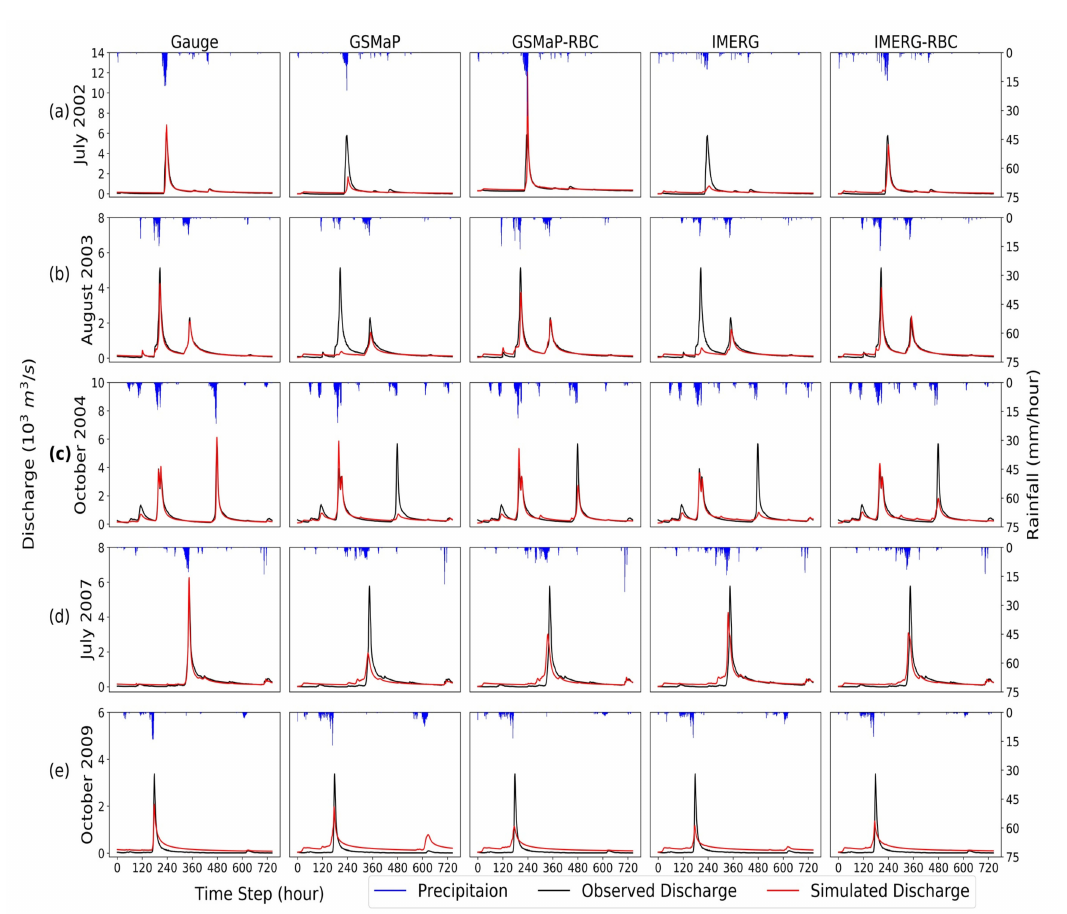
Figure 6. Flood discharge simulation at Kitamatsuno by using five precipitation datasets for five cases. ( a )–( e ) represent five cases respectively. ( c ) is the calibration period, while others are the validation